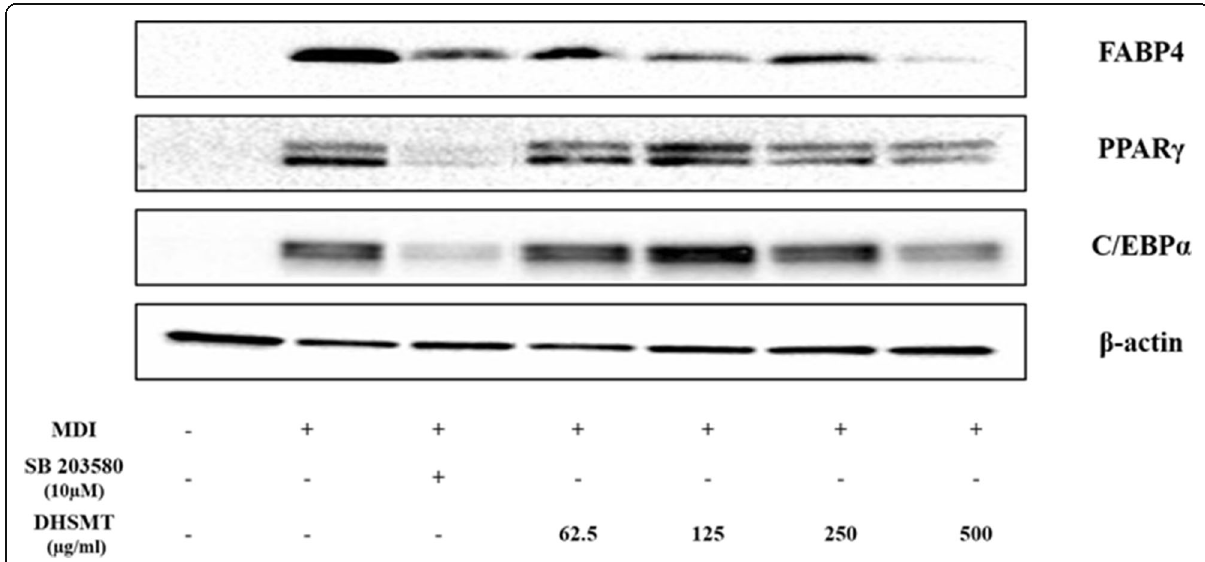
Fig. 6 Effects of DHSMT on protein expressions of adipogenic-transcription factor during adipogenesis. 3T3-L1 adipocytes were exposed to various concentrations of DHSMT and SB203580 during the differentiation period. Cell lysates was isolated and protein expressions of PPAR γ , C/EBP α and FABP4 were determined by western blot analysis. ß -actin was used as a